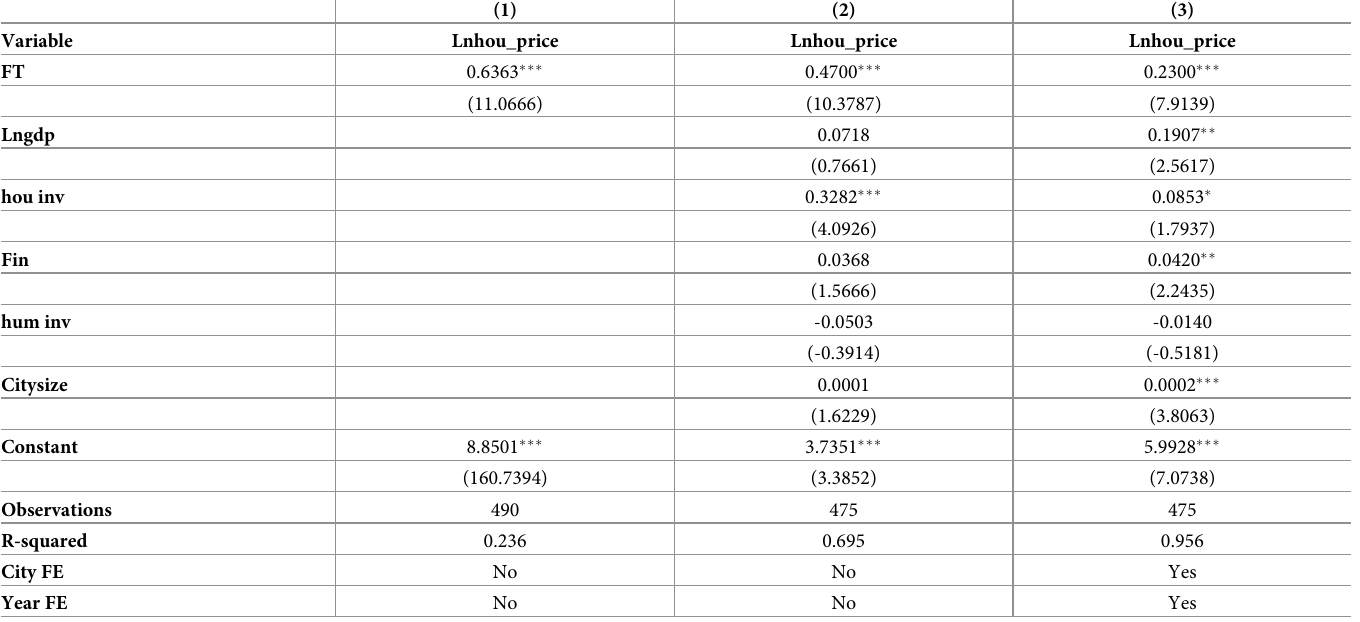
Table 3. The impact of NTSP on housing